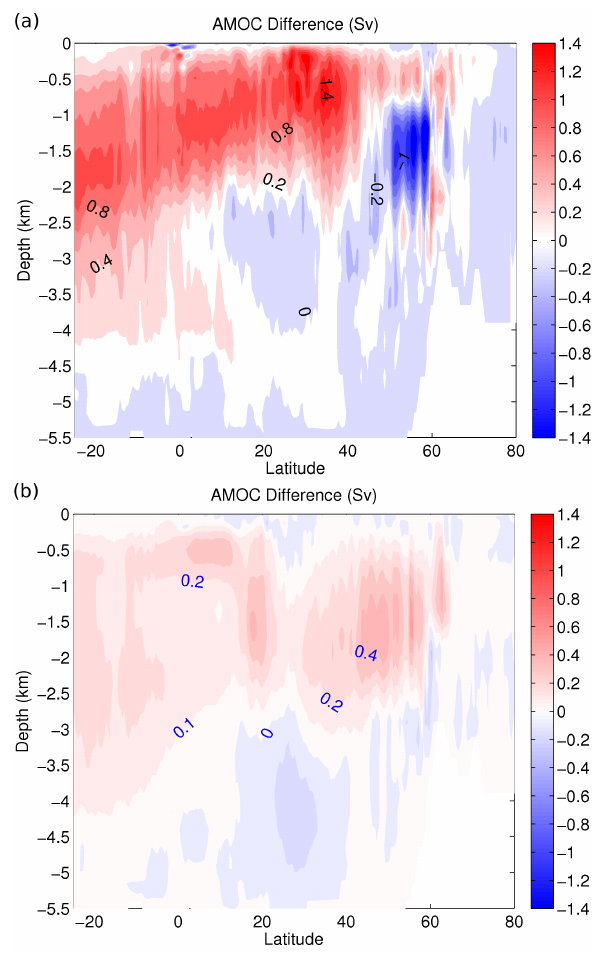
Fig. 114. The same as Fig. 113 but for AMOC (Sv). Fig. 14. The same as Fig. 13 but for AMOC (Sv).